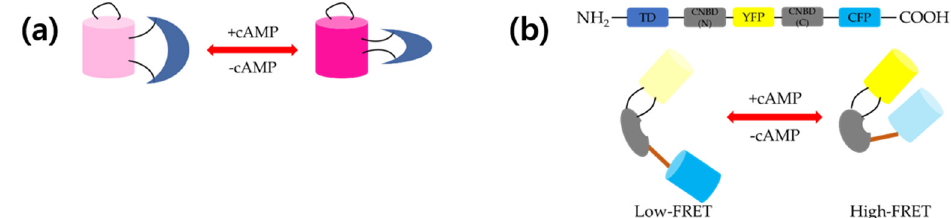
Figure 1. Schematic representation of ( a ) structure and working mechanism of Pink Flamindo and ( b ) protein kinase A (PKA)-based 3′-5′-cyclic adenosine monophosphate (cAMP) sensor cAMP universal tag for imaging experiments (CUTie). Pink Flamindo is a single fluorescent protein (FP)-based sensor. Binding of cAMP enhances fluorescence and vice versa . Without cAMP, two fluorescent proteins are apart from each other (low Föster resonance energy transfer (FRET)), whereas two FPs are close to each other in the presence of cAMP (high FRET).